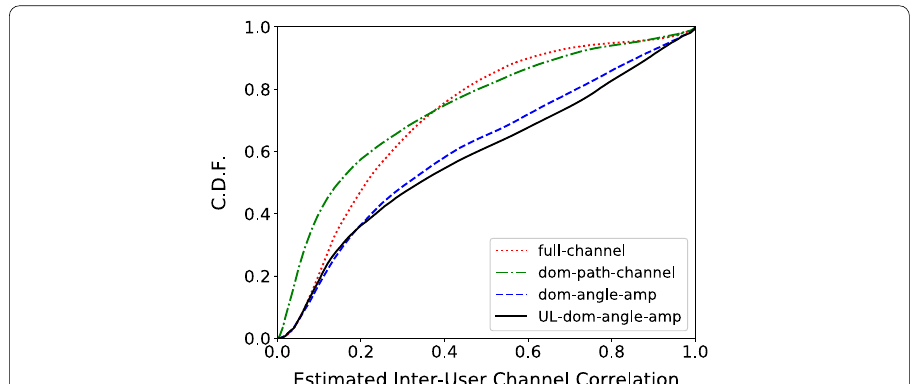
Fig. 3 The cumulative distribution function of estimated downlink inter-user channel correlation for all measured channels. This includes estimations by utilizing full downlink channel (labeled as full-channel), approximated downlink channel with downlink dominant angles (labeled as dom-path-channel), downlink dominant angles and amplitudes (labeled as dom-angle-amp), and uplink downlink dominant angles and amplitudes (labeled as UL-dom-angle-amp),